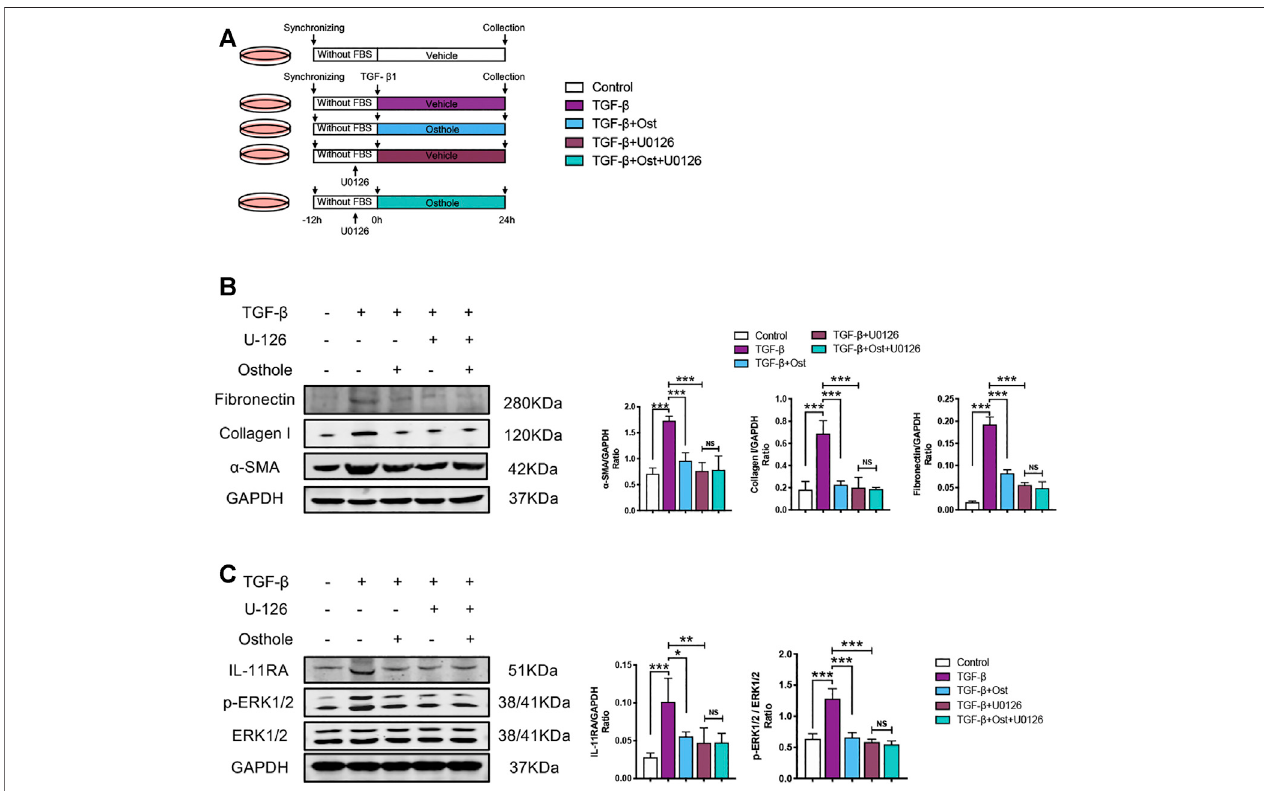
FIGURE5| IL-11/ERK1/2inhibitionpartlyblockstheanti fi brogeniceffectsofosthole. (A) invitro experimentalprotocolofthispart. (B) Representativewesternblots for α -SMA, collagen I and fi bronectin protein expressions in HK-2 cells; the quanti fi cation of α -SMA, collagen I and fi bronectin western blots. ( n (cid:1) 4 repeats) (C) RepresentativewesternblotsforIL-11RA, p -ERK1/2andERK1/2proteinexpressionsinHK-2cells;thequanti fi cationofIL-11RA, p -ERK1/2andERK1/2westernblots. ( n (cid:1) 4 repeats). All data are presented as means ± SD. * p < 0.05, ** p < 0.01, *** p <